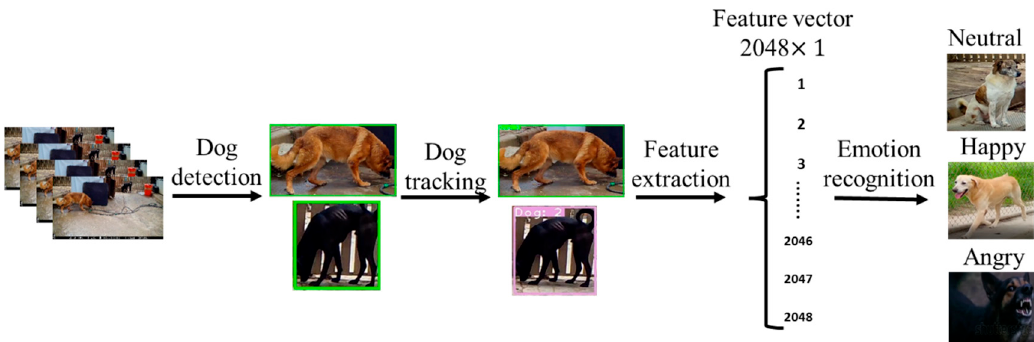
Figure 1. Dog emotion recognition process.